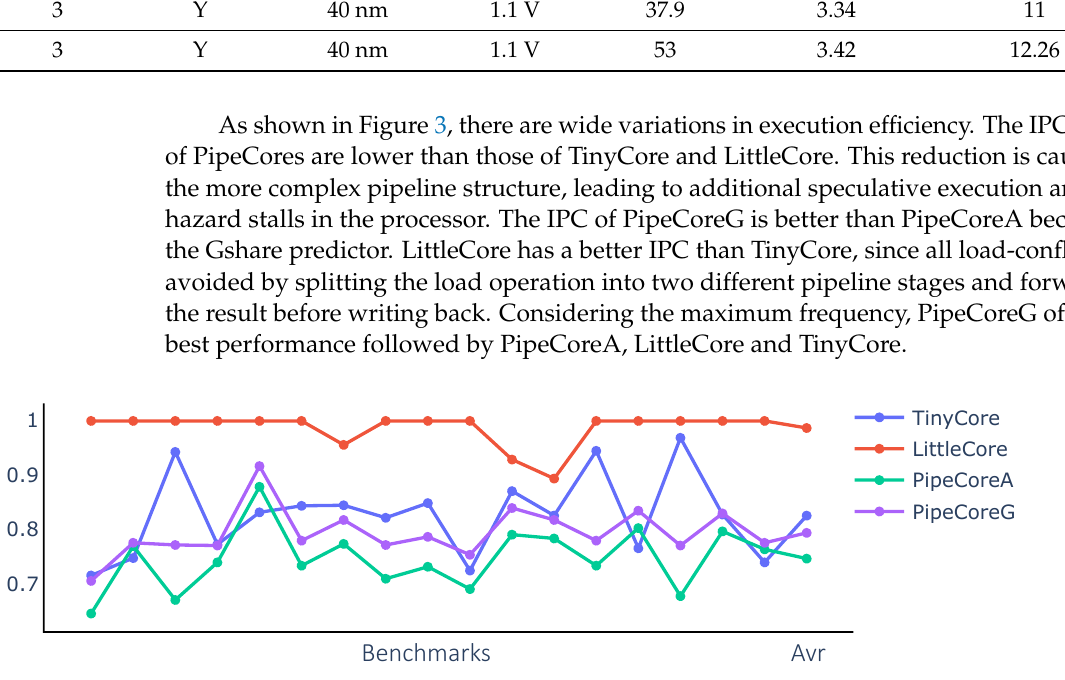
Figure 3. Instructions per cycle (IPC) of baseline